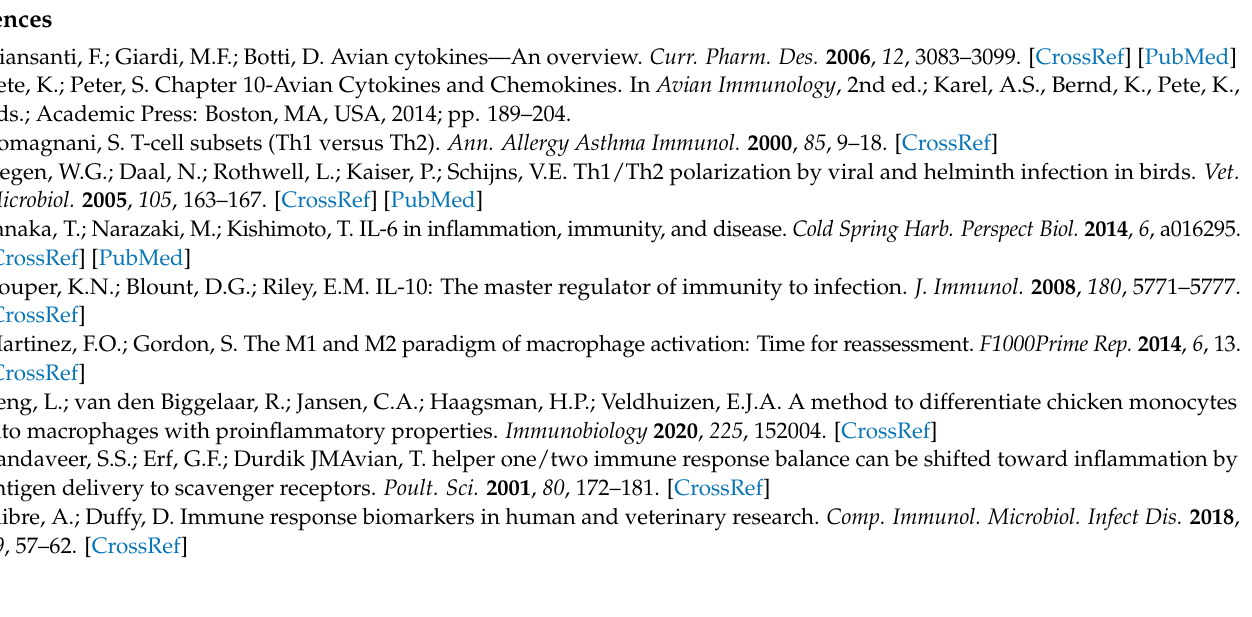
Figure 3. Checkerboard titration of capture antibody (cAb) at ( a ) 2.5 µg/mL, ( b ) 0.83 µg/mL, ( c ) 0.28 µg/mL, and ( d ) 0 µg/mL and titration of detection antibody ( dAb) with 10,000, 1000, 100, and 0 ; Table S1: Lower limit of detection (LLOD) in 5% chicken serum which is simulating more pg/mL recombinant IL-2 from left to right represented by . Titration was performed to check complex matrix of cell culture for the best combination of antibodies in a broad range of cytokine concentrations.